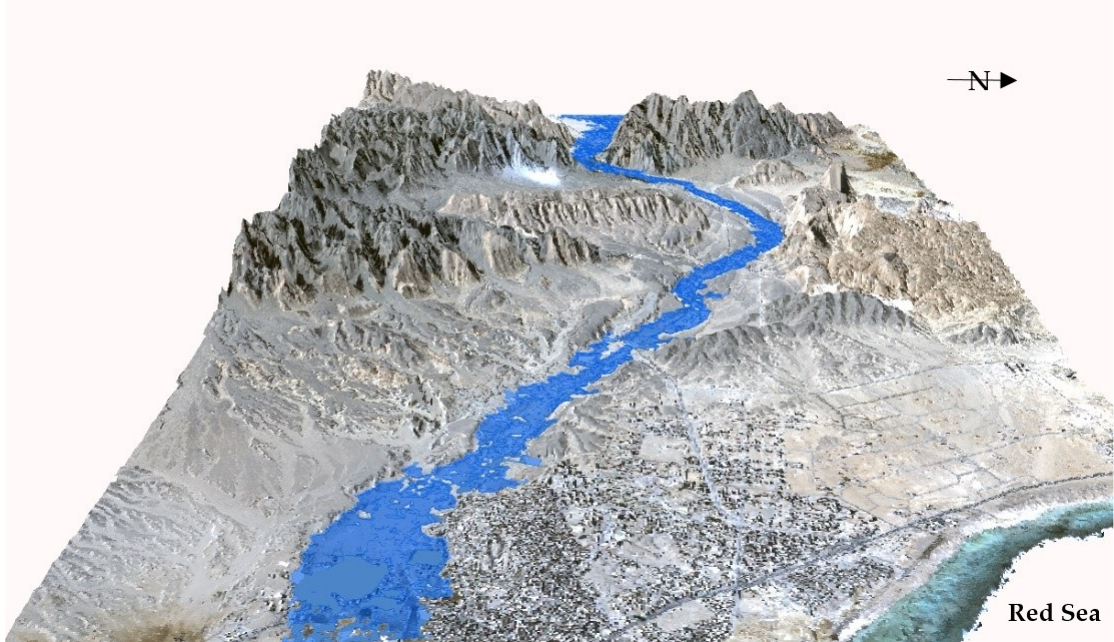
Figure 9. Modeled flood map for the downstream area of Wadi El-Ambagi based on a 60-mm precipitation event with a peak flow of 875 m 3 s − 1 m 3 s − 1 . This flood would surge the eastern flank of the town of Quseir with flood waters up to 2 m